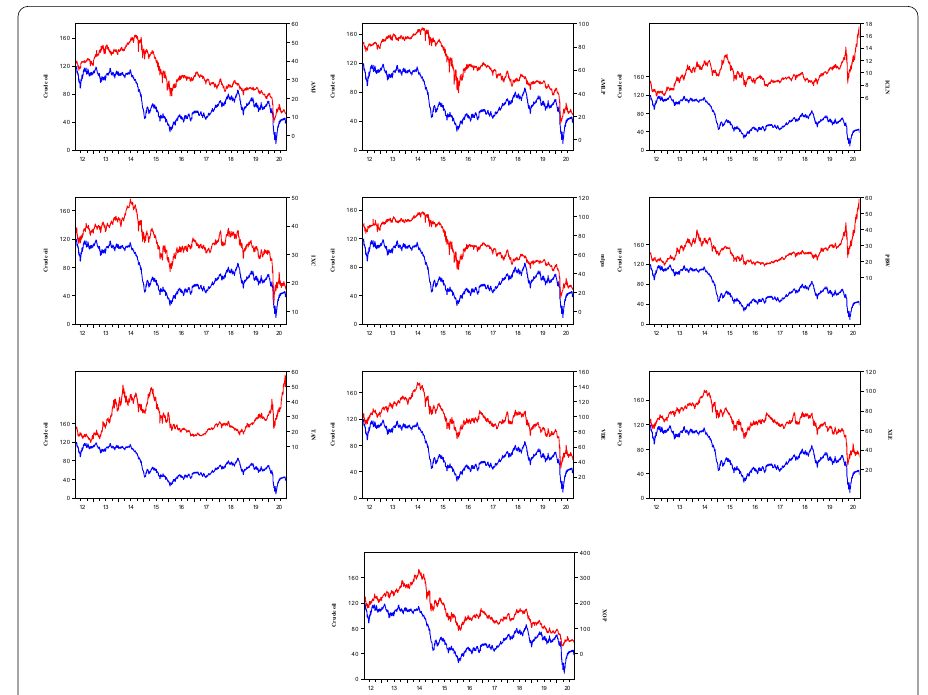
Fig. 2 Co-movements between energy sector ETFs and crude oil